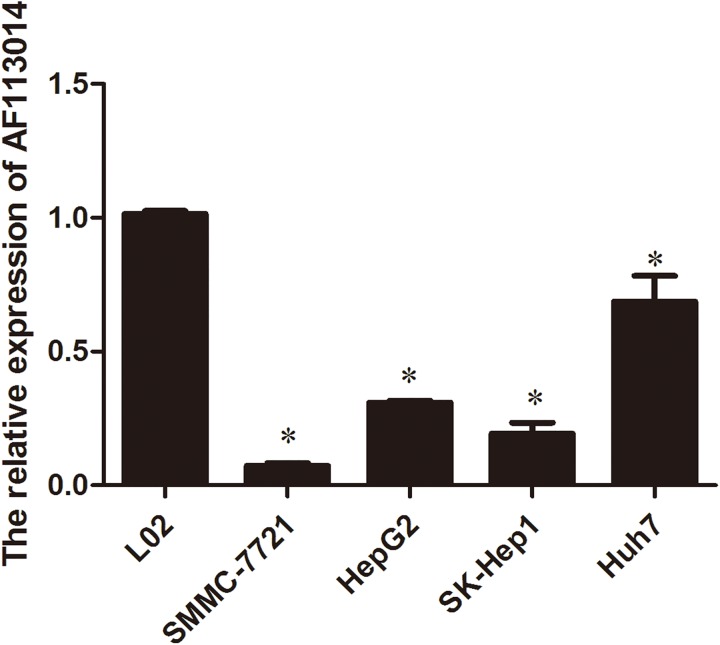
Expressions of AF113014 were down-regulated in HCC cell lines.lncRNA-AF113014 expressions in L02 and HCC cell lines. *P<0.05 vs L02.